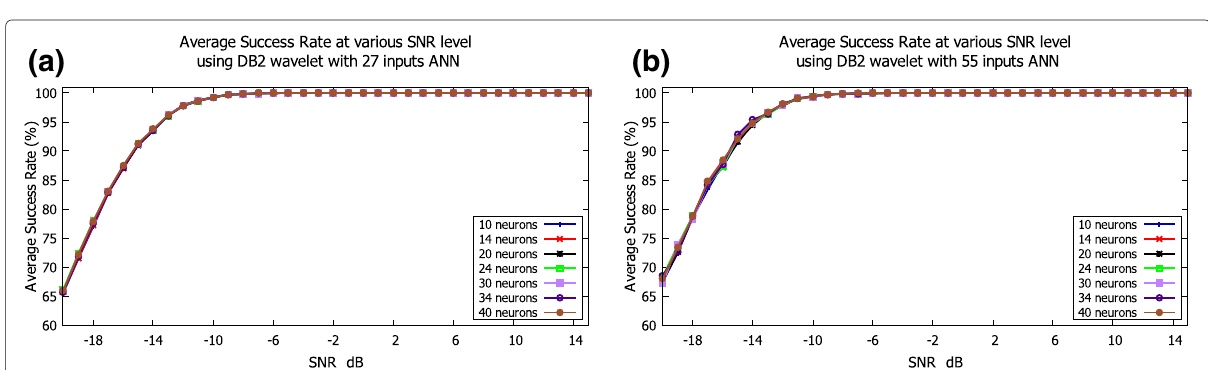
Fig. 9 The probability of correct classification (success rates) in AWGN channel when applying a DB2 wavelet connected to FFNN with 10, 14, 20, 24, 30, 34, and 40 hidden neurons. a Using 5-Level DB2 DWT (27 coefficients), b Using 4-Level DB2 DWT (55